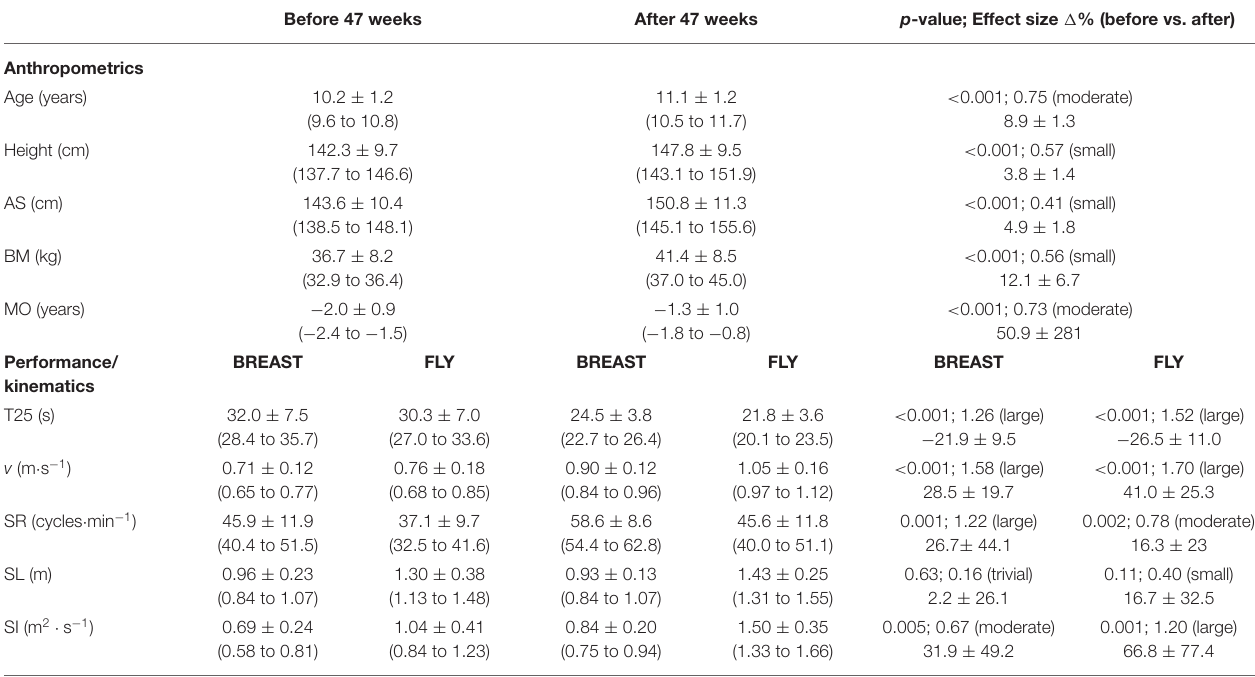
TABLE 1 | BEFORE and AFTER 47 weeks (47w) mean ± SD values (95% confidence intervals), p -values, effects sizes (Hedges’ g), and 1 % for anthropometric and performance/kinematics ( n = 20). Before 47 weeks After 47 weeks p -value; Effect size 1 % (before vs. after)